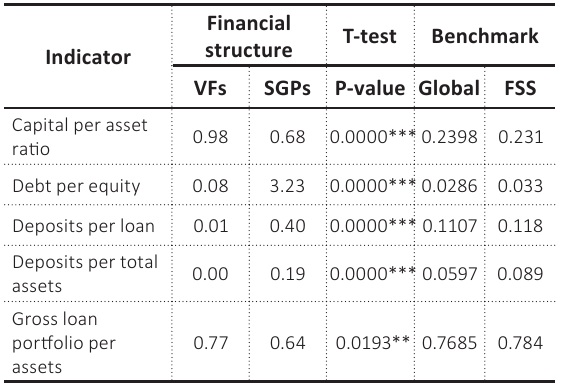
Table 3. Comparison of Thai MFIs’ financial structures (mean values from 2014 to 2016)